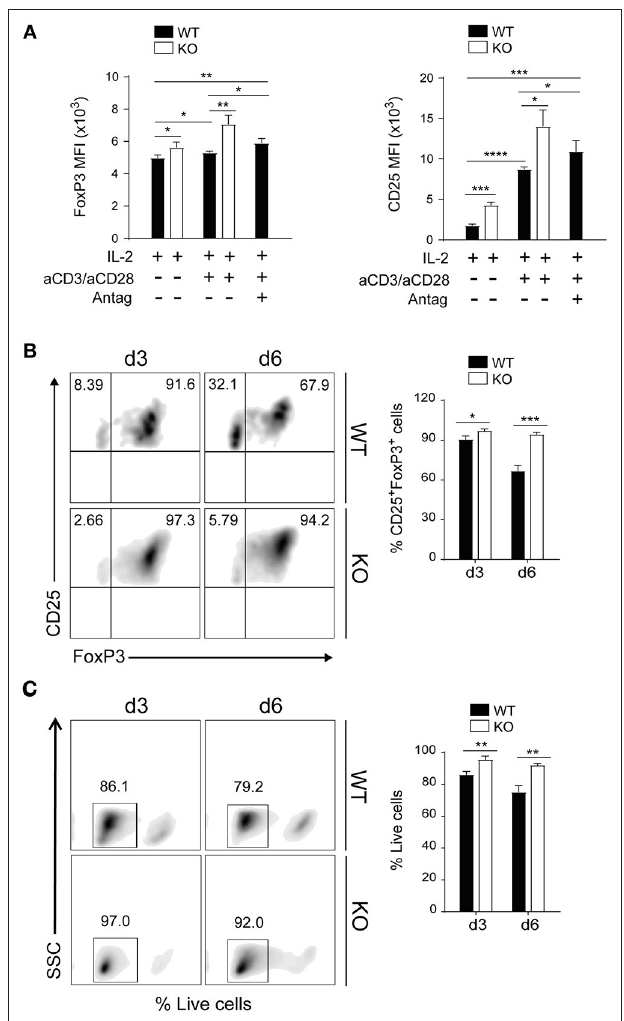
FIGURE 2 | PAR4 signaling regulates stability and survival of Foxp3 + Tregs in vitro . CD4 + CD25 + Tregs were freshly isolated from spleen and pLNs of WT (filled bars) and PAR4ko (open bars) mice. The Tregs were activated with anti-CD3/anti-CD28 in the presence of IL-2 for 3 days and in some cases PAR4 antagonist (Antag) was added to WT Tregs. The MFI levels of FoxP3 and CD25 expression were analyzed by flow cytometry (A) . Flow cytometry assessment of FoxP3 and CD25 expression on Tregs activated by anti-CD3/anti-CD28 in presence of IL-2 for 3 and 6 days (B) . Flow cytometry assessment of live Tregs activated by anti-CD3/anti-CD28 in presence of IL-2 for 3 and 6 days (C) . The cells were stained with live/dead near-IR dead cell stain kit. Graphs show mean ± SEM from four experiments. Data were analyzed by unpaired two-way t -test. * p < 0.05, ** p < 0.005, *** p < 0.0005, and **** p < 0.0001 in comparison between WT and PAR4ko